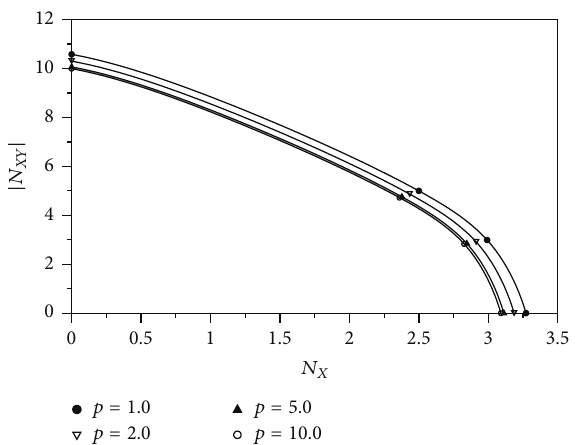
Figure 10: Buckling load of FGM plates with various power law index: combined compressive and shear